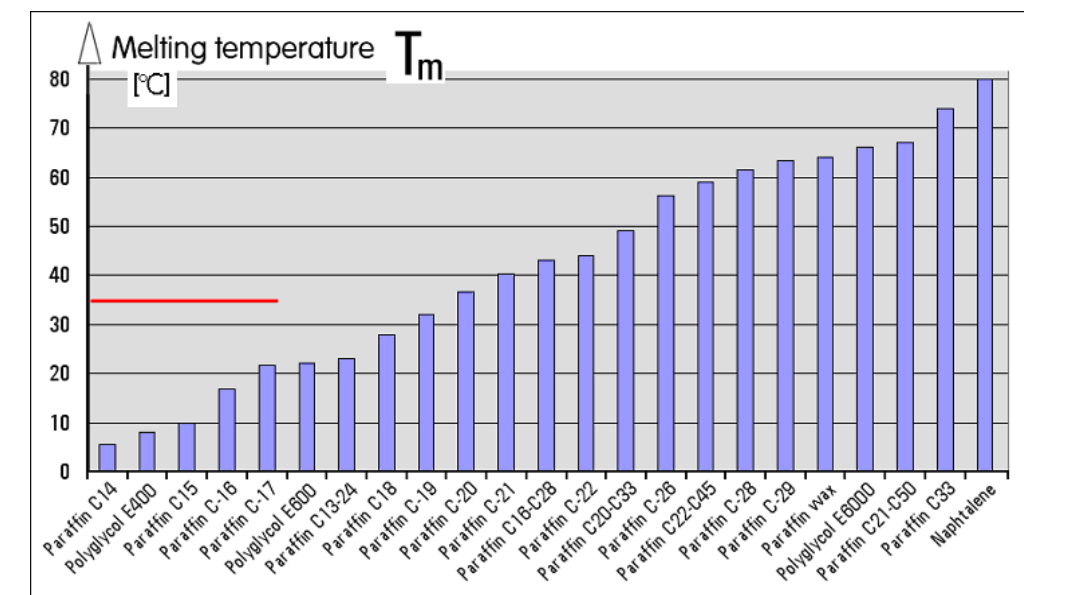
Fig. 5. Present prevailing development interests in application of latent heat storage tend to concentrate on keeping comfortable thermal conditions for humans (red line) and also of devices and instruments that should be comfortably touched even if they generate heat. As shown here, existing range of commercially available paraffins offers a suitable choice of the melting temperature level.